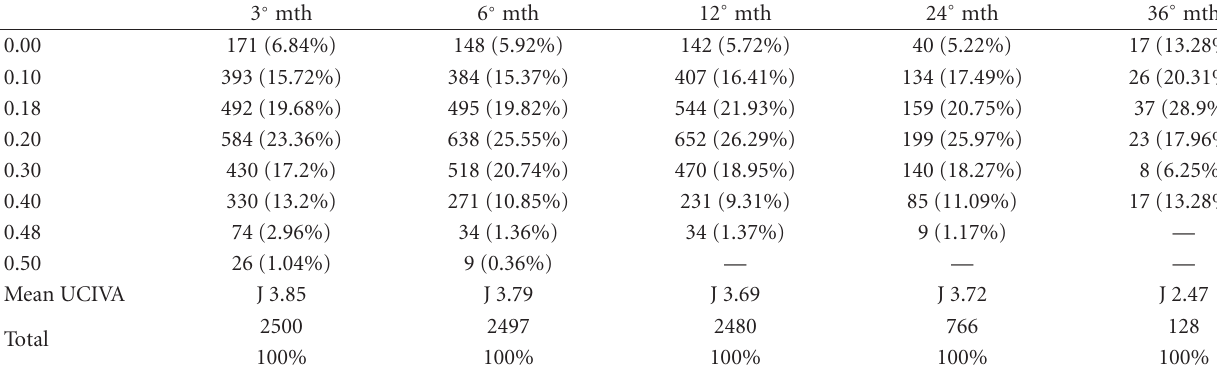
Table 6: UIVA in each postoperative